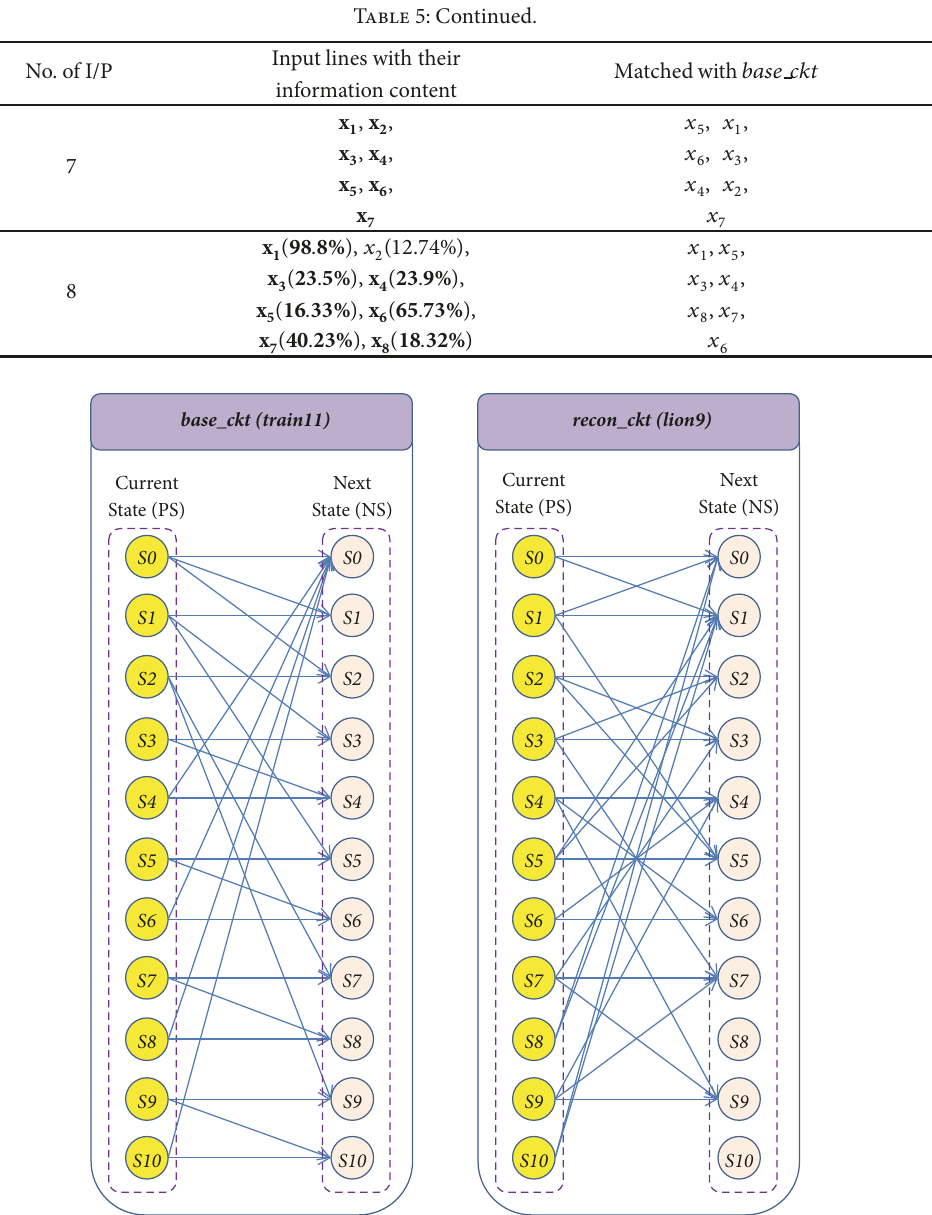
Figure 4: The pictorial representation of state transitions for 𝑏𝑎𝑠𝑒 𝑐𝑘𝑡 and 𝑟𝑒𝑐𝑜𝑛 𝑐𝑘𝑡